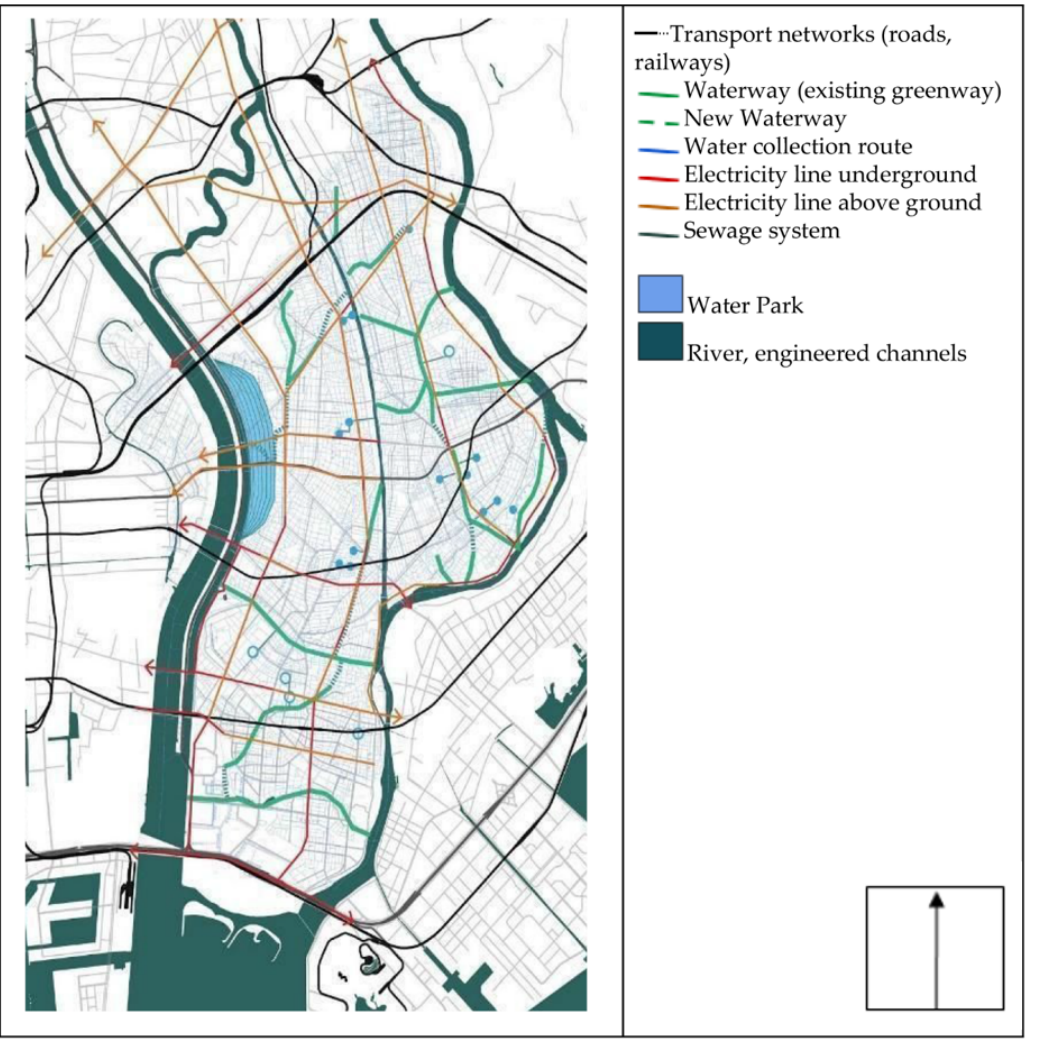
Figure 12. Strategy A—anti super levee overlaid with vital infrastructure (electricity, transport, sewage) (source: drawn using data from MLIT Japan and the Edogawa ward data, 2016)